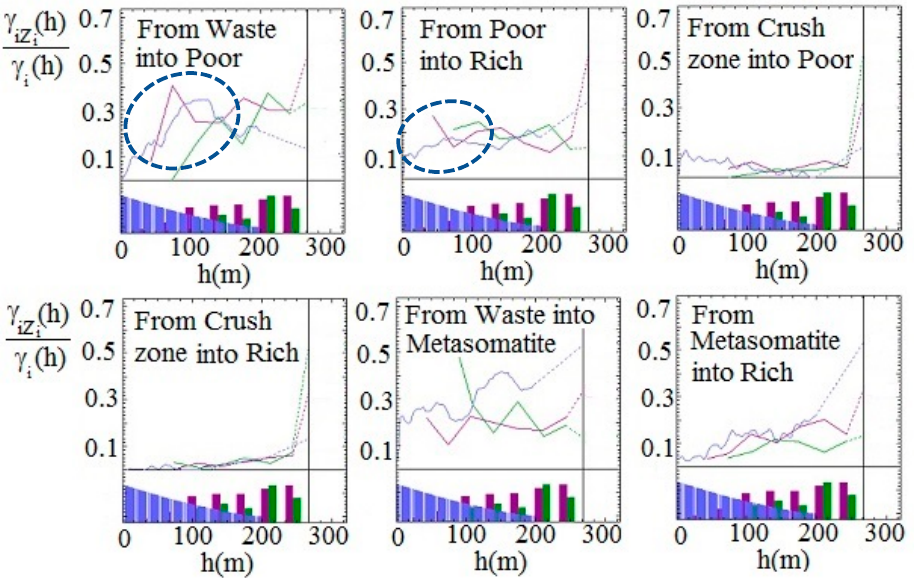
Figure 12. Variogram ratio between indicator and partial grade divided by indicator variogram in three directions (vertical direction: blue, horizontal directions (0, 90): red and green).